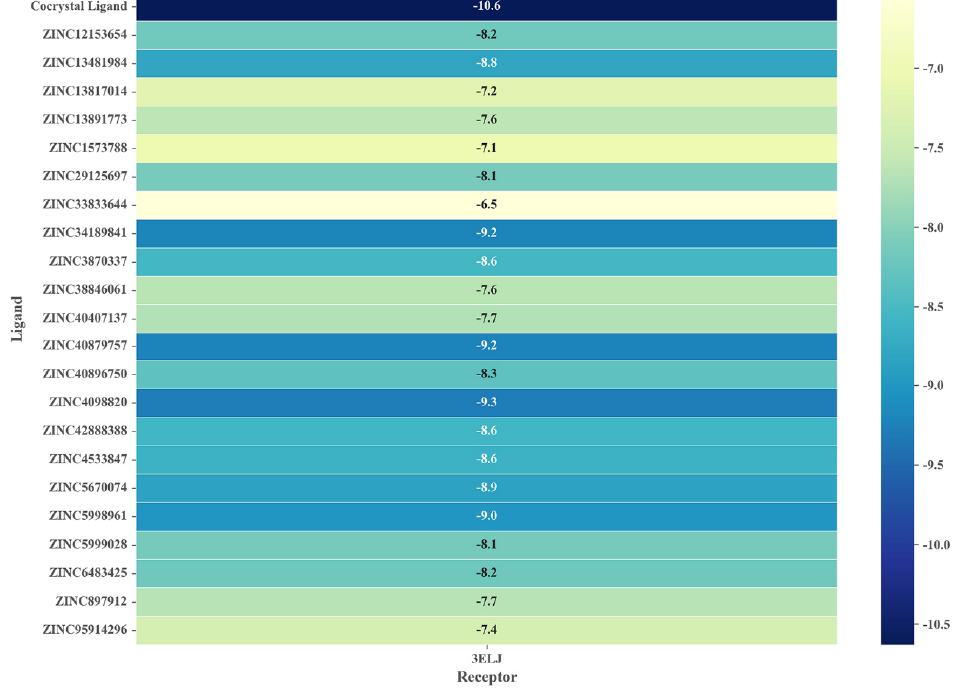
Figure 4. The affinity of 22 screened hits to the target protein (PDB ID: 3ELJ).